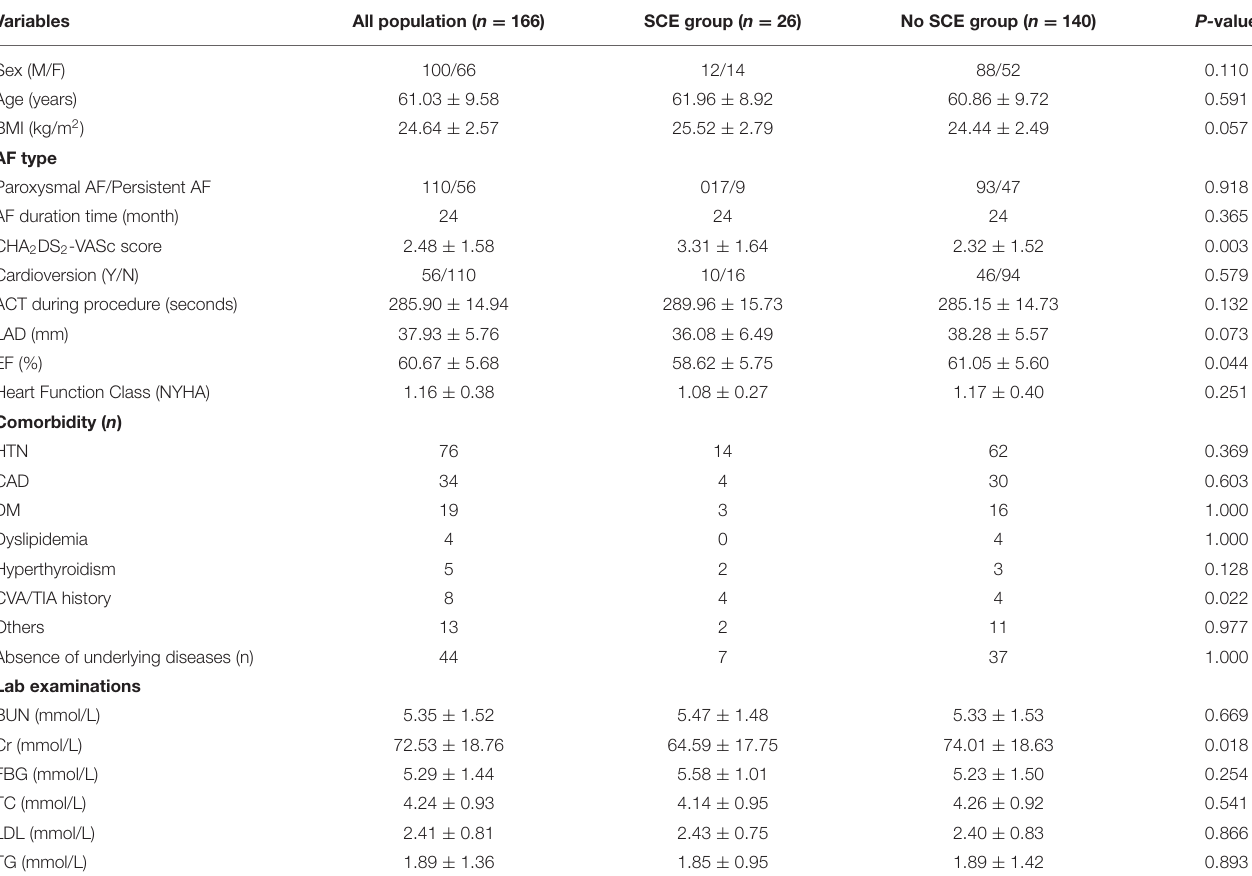
TABLE 2 | Characteristics of patients with SCE and without SCE.